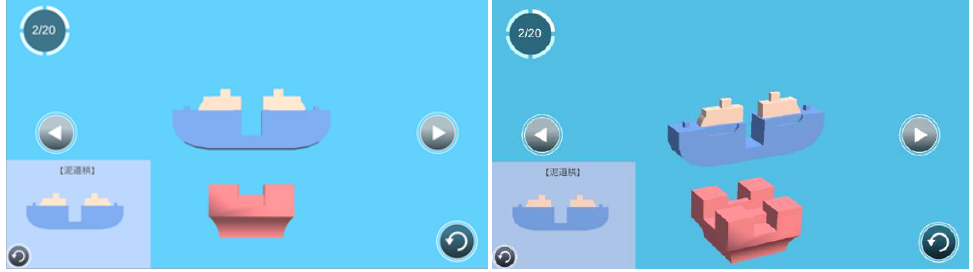
Figure 6. Screenshots of assembly demonstration function.